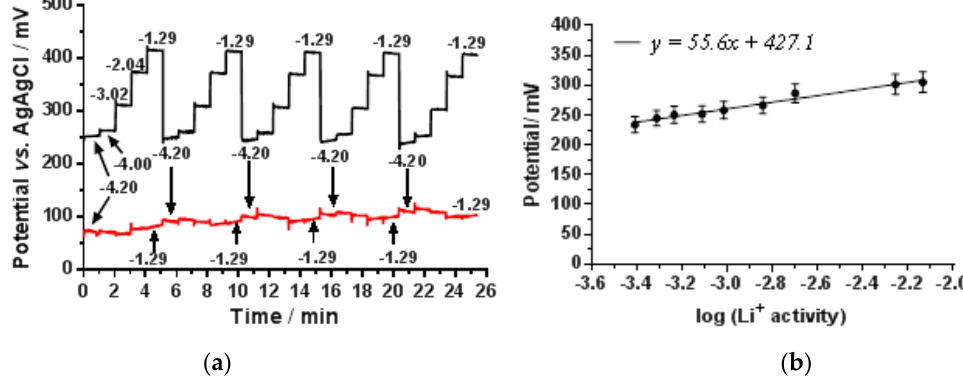
Figure 3. ( a ) The potentiometric response vs. time of the Li + sensor (black) and the fiber reference electrode (red) vs. Ag/AgCl double junction reference electrode with varying concentrations of LiCl solutions. The values on the plots are log (Li + activity); ( b ) the average potentiometric response of Li + sensor vs. the fiber reference electrode measured in LiCl solution (0.1–63.0 mM) in 0.1 ml spiked plasma (n = 5